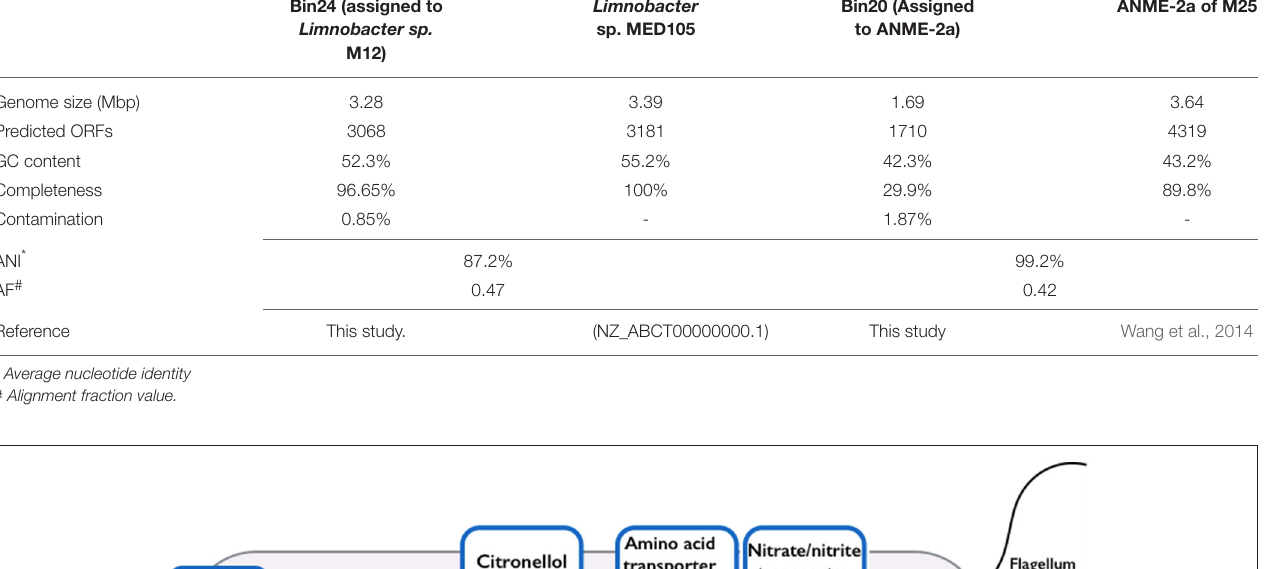
protein, aapQ and aapM , which encode two permeases serving in the cross-membrane transport of L-amino acids, and aapP , which encodes an ATP-binding protein. The